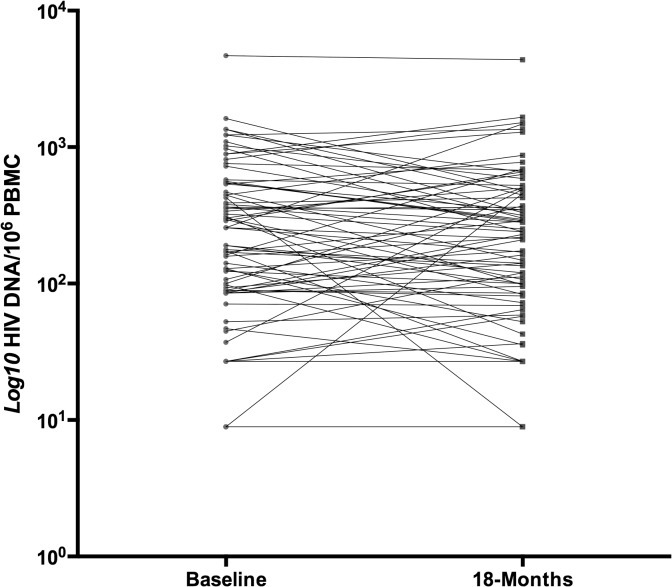
Baseline and follow-up log10 HIV DNA per 106 PBMC.